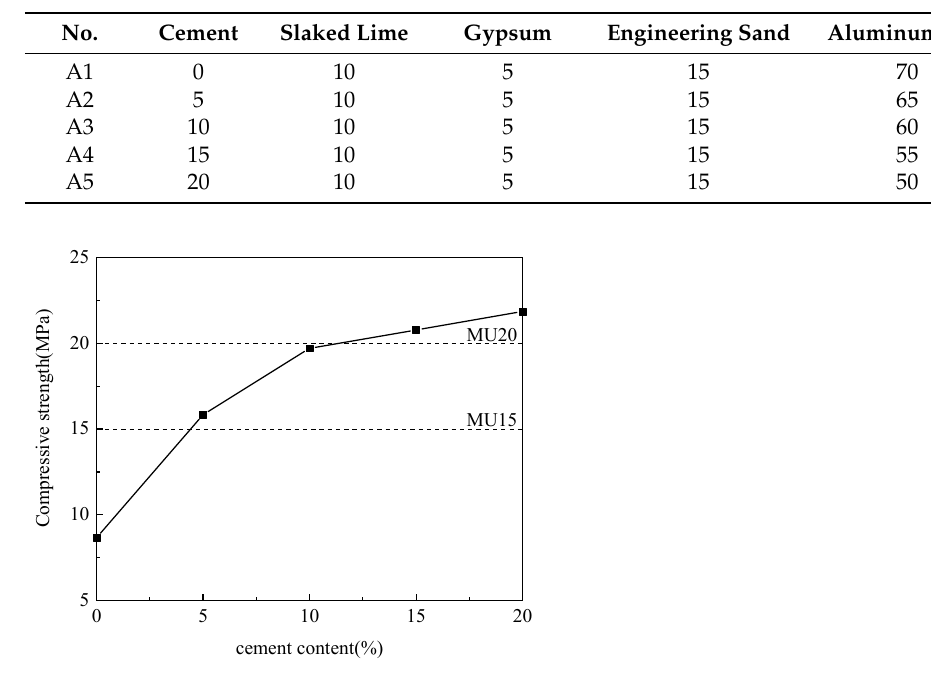
Figure 3. Morphology of aluminum ash.